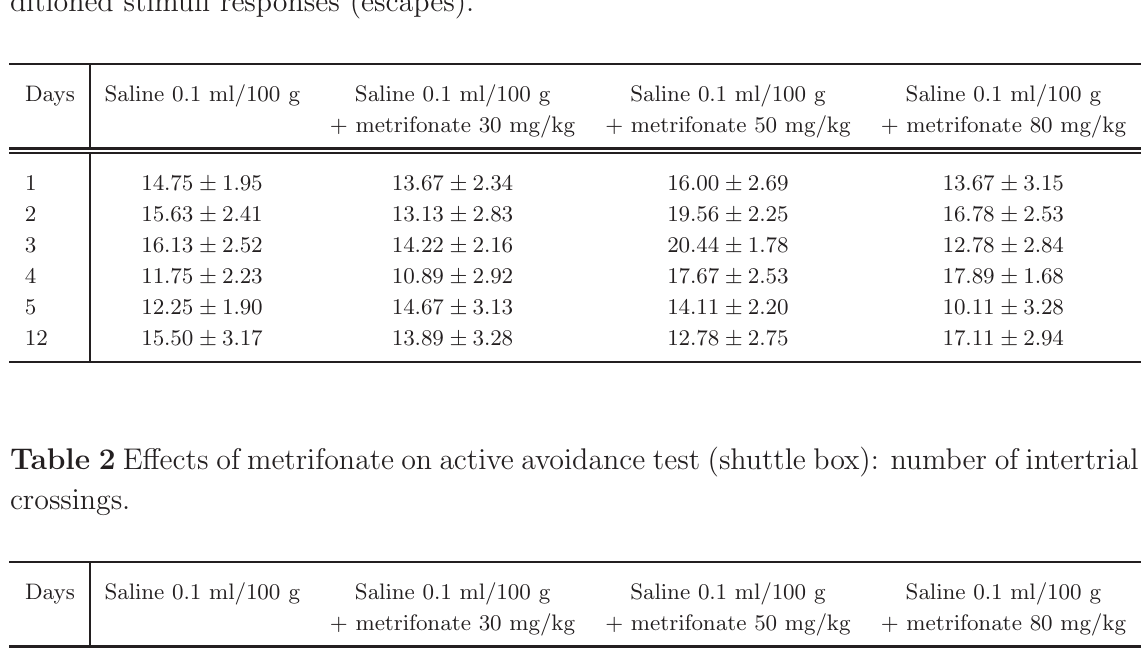
Table 1 Effects of metrifonate on active avoidance test (shuttle box): number of uncon- ditioned stimuli responses (escapes).